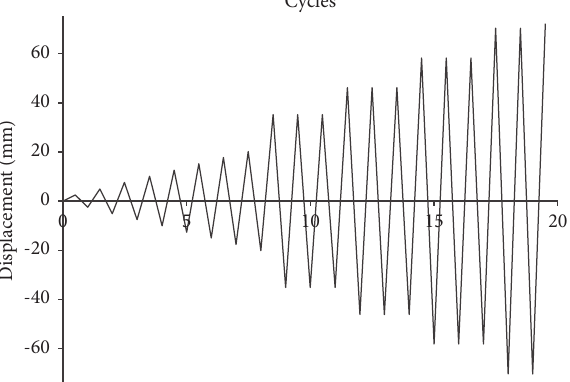
Figure 4: Loading system of the